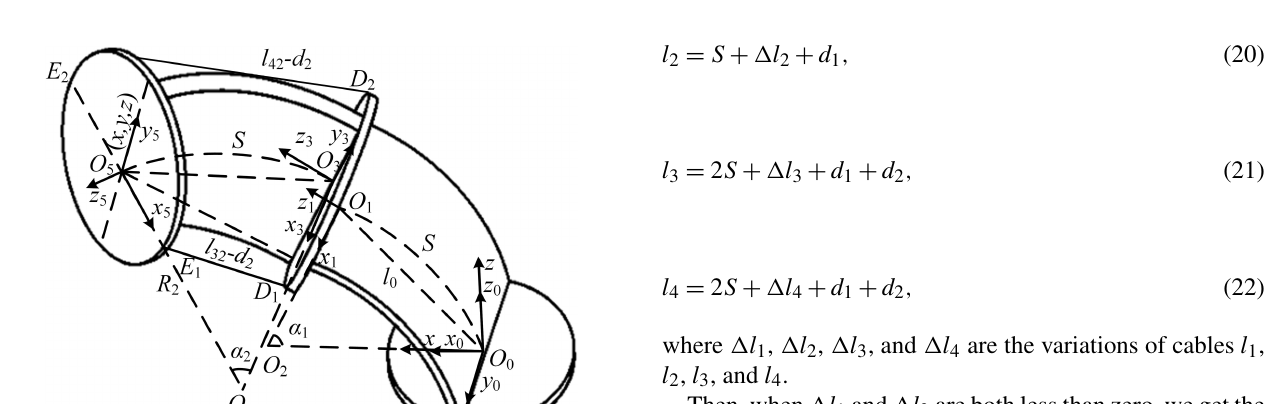
Figure 4. Geometry of the bending of the first bending section about the y 0 axis.